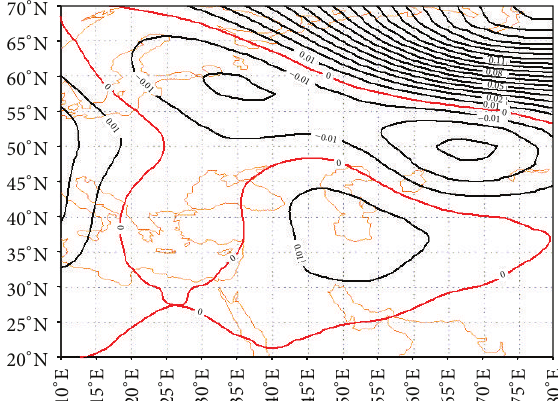
Figure 18: The first component of 500 HPa geopotential height level